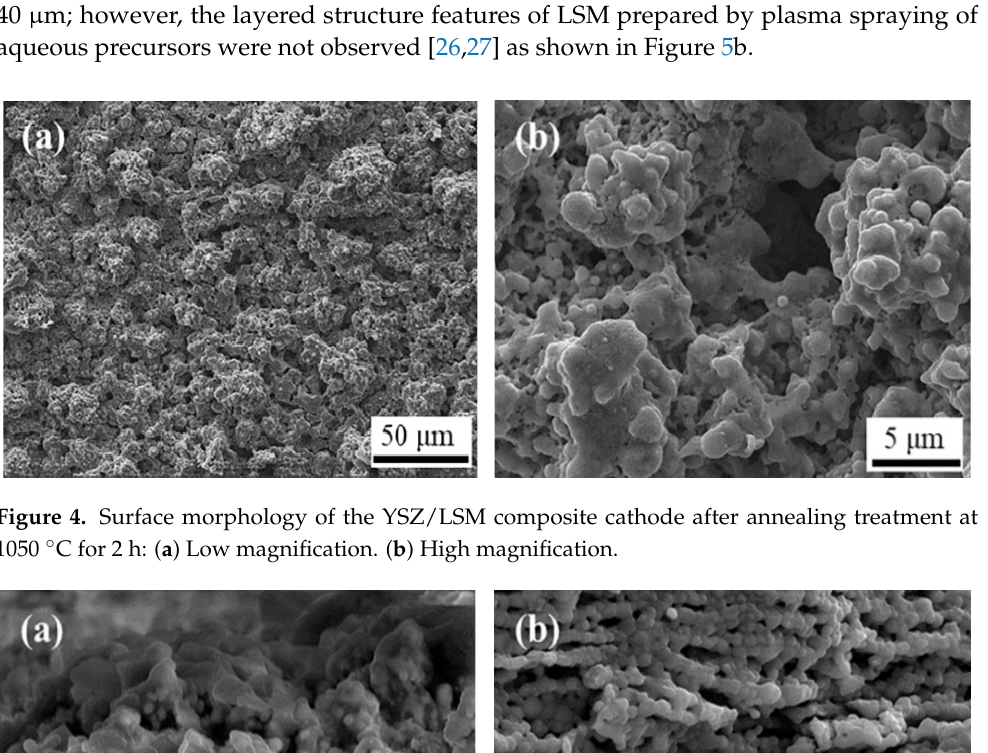
Figure 4. Surface morphology of the YSZ/LSM composite cathode after annealing treatment at 1050 °C for 2 h: ( a ) Low magnification. ( b ) High magnification.